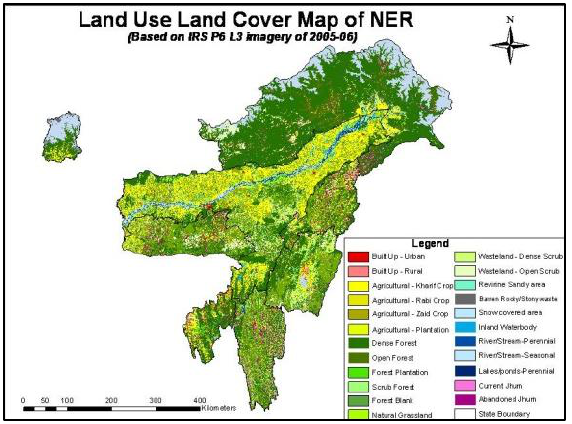
Figure 3. Land Use / Land Cover map of NER